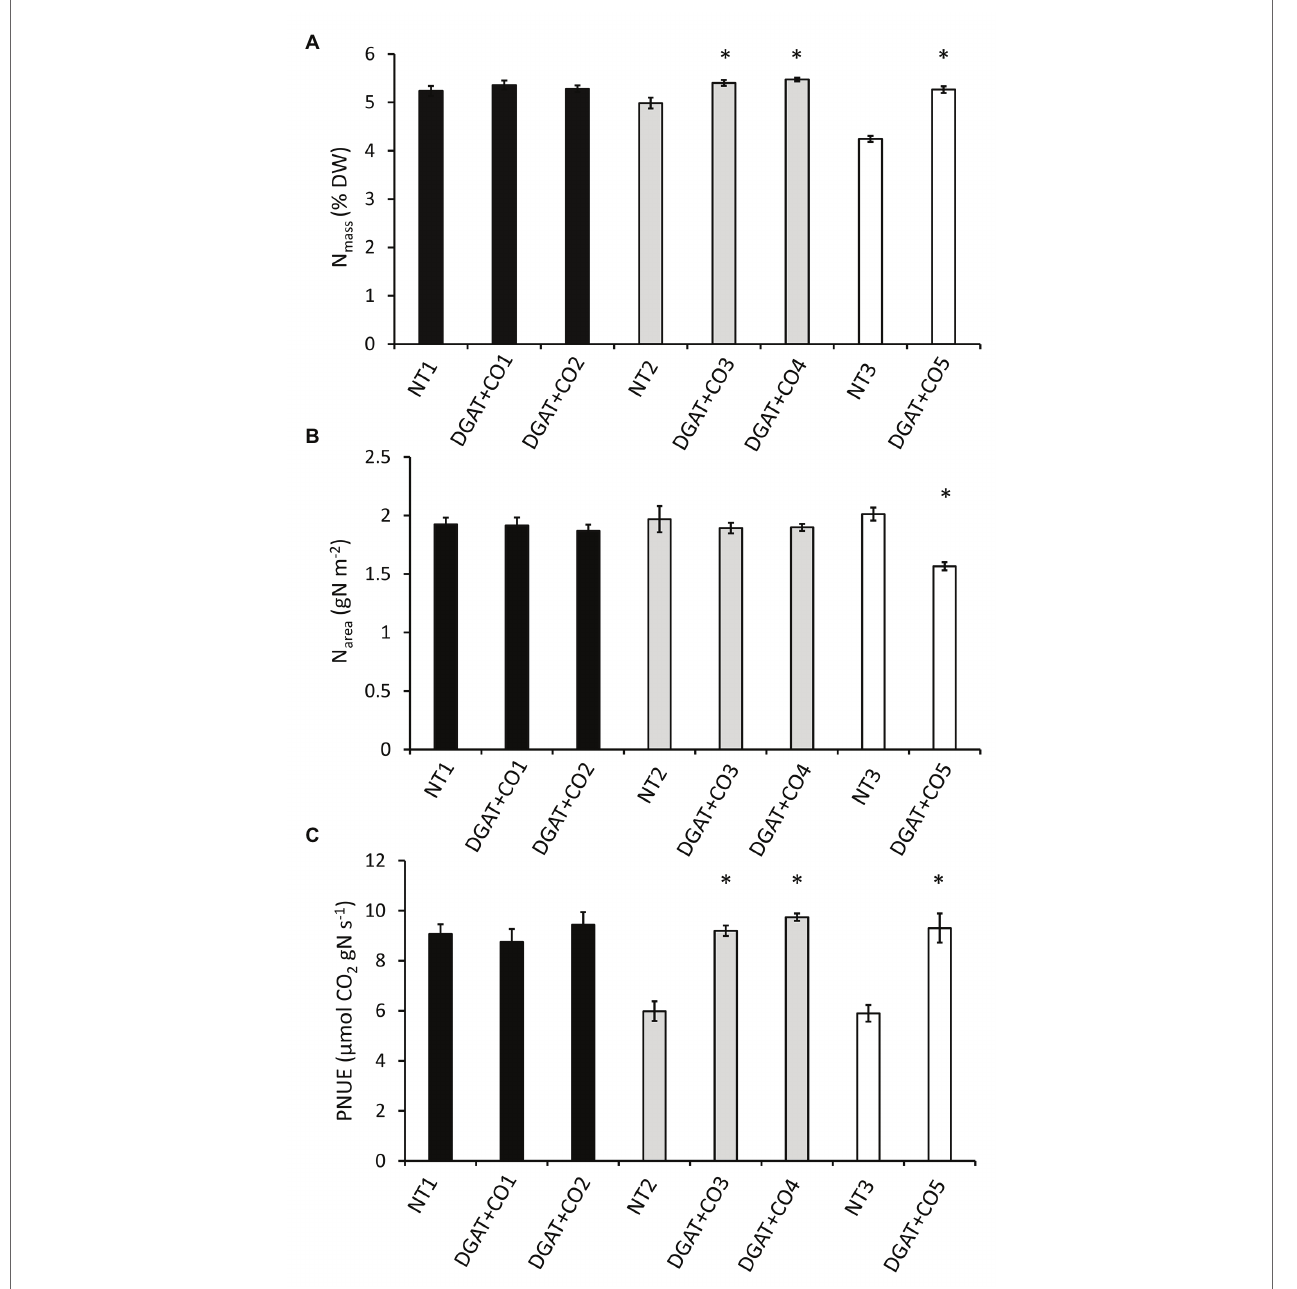
FIGURE 4 | Leaf N concentration (N mass ; A ), N per unit leaf area (N area ; B ) and photosynthetic nitrogen use efficiency measured at 600 μ mol photons m −2 s −1 (PNUE amb ; C ) for five independently transformed DGAT + CO L. perenne lines and respective NT controls. Means ± SE. * Statistically differs from NT, p < 0.05; n = 10. Matching genetic backgrounds are shaded